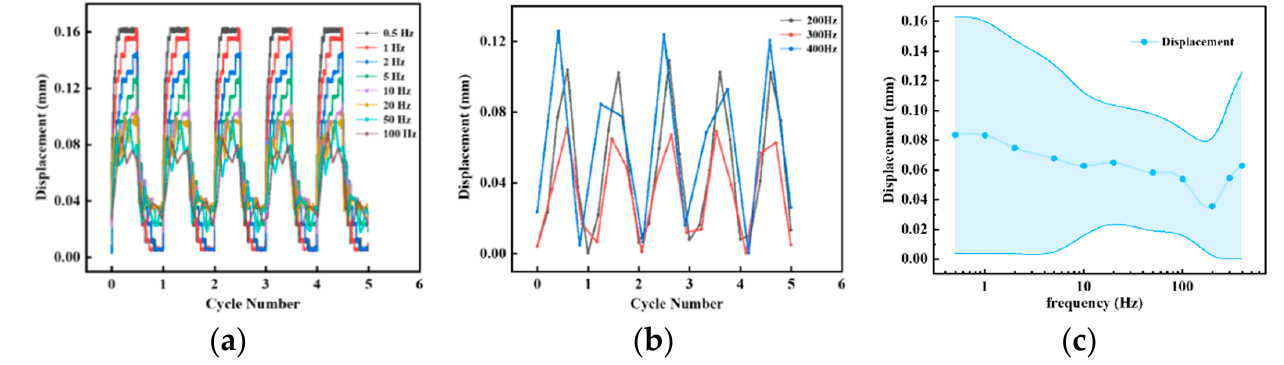
Figure 11. Displacements of SEHPA under the cyclic loading of 5 kV, with the loading frequencies of ( a ) 0~100 Hz and ( b ) 200~400 Hz. ( c ) The frequency response graph of the actuator displacement (mm) vs. actuation frequency (Hz). The loader pressure was 5 kPa.